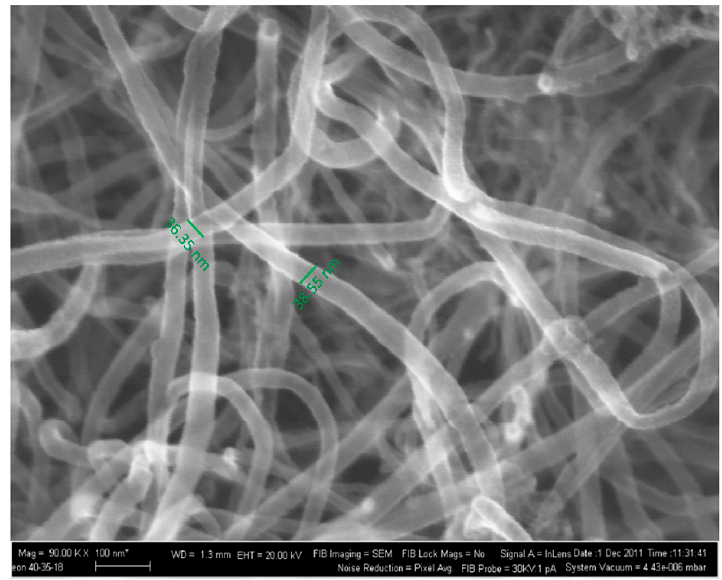
Figure 4. The structure of